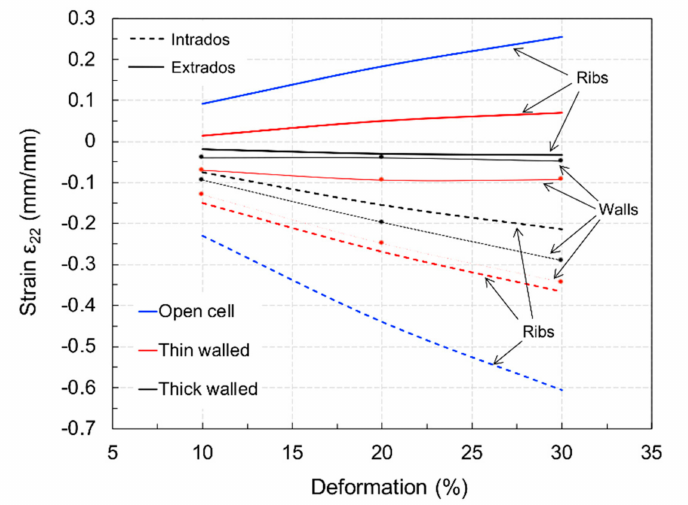
Figure 14. Strain in ribs and walls at the intrados and extrados of the cell structures.